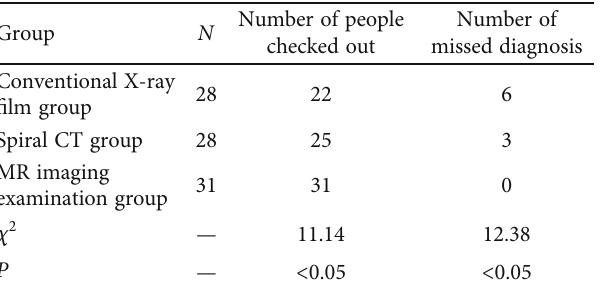
Figure 2: Flow chart of imaging diagnosis test for patients with shoulder pain caused by sports Table 1: Detection of shoulder joint injuries in three groups of patients.